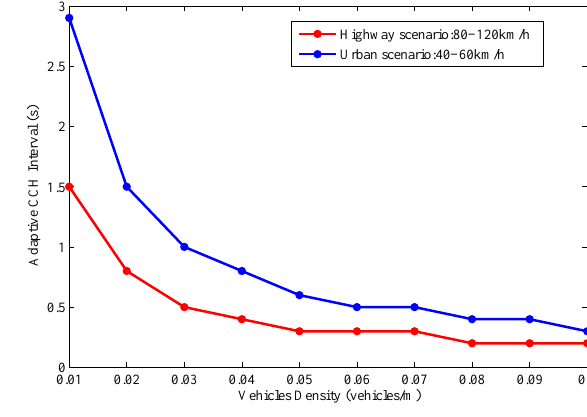
Figure 5. Adaptive CCI versus vehicle’s density